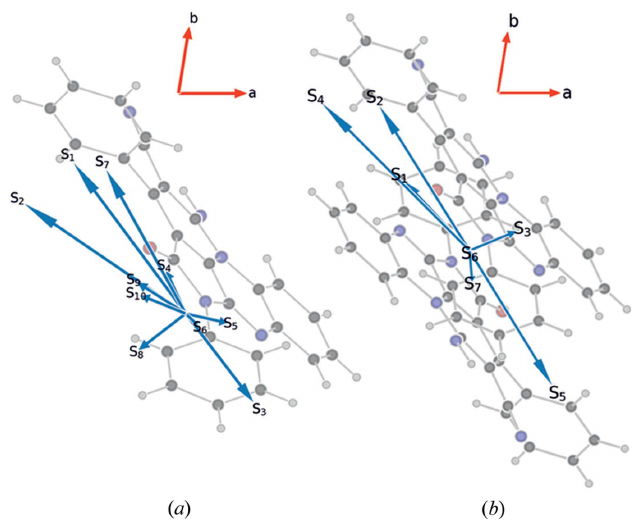
Figure 10 The orientation of the calculated transition dipole moments (TDMs) for ( a ) the TAAP monomer and ( b ) the TAAP dimer in relation to both the chromophore plane and the crystallographic plane (001). All TDMs except S 8 of the monomer and S 3 of the dimer are approximately aligned along the [110]